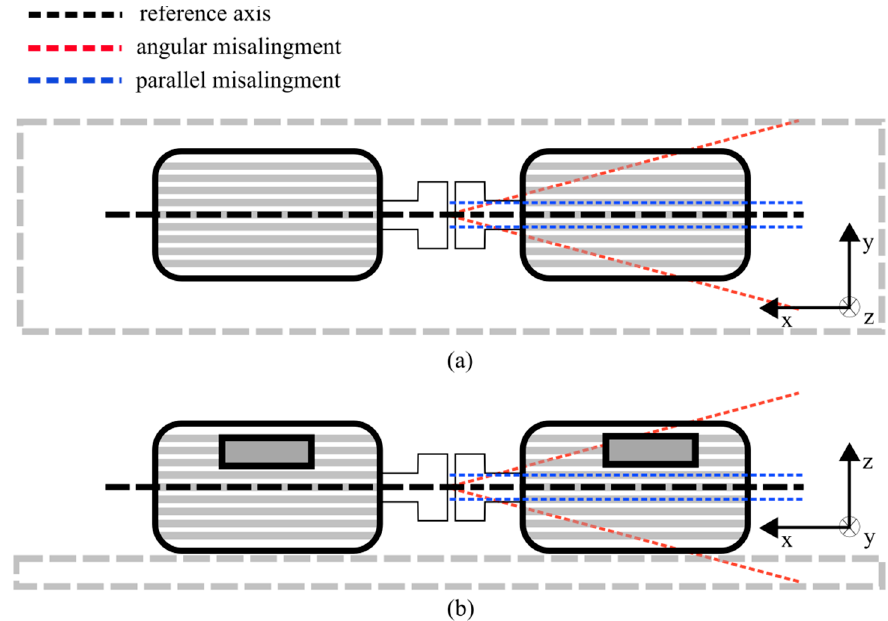
Figure 2. Misalignment fault description, ( a ) horizontal plane and ( b ) vertical plane.